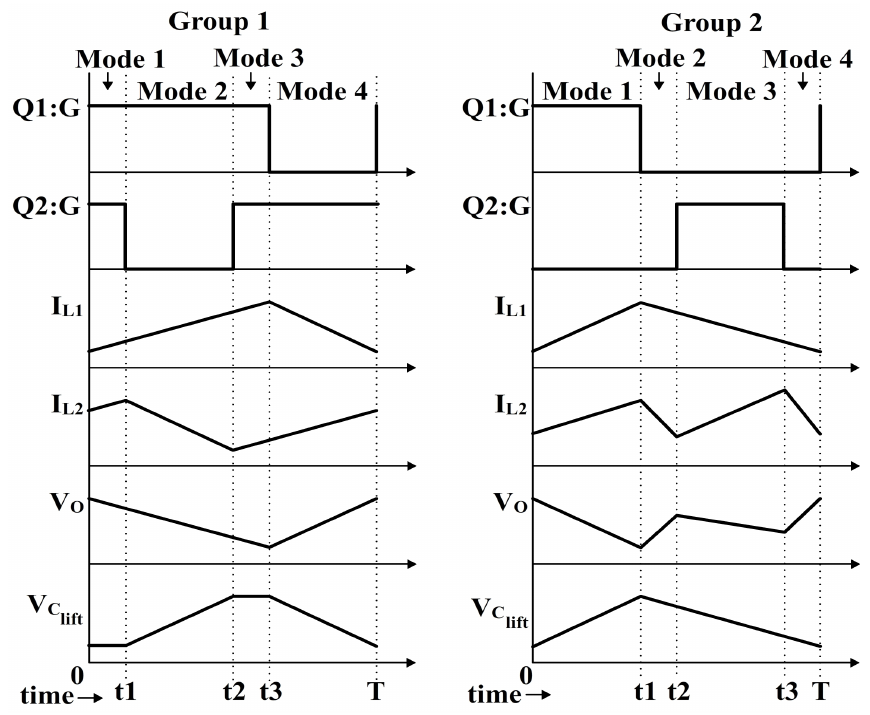
Figure 2. Characteristic waveforms during